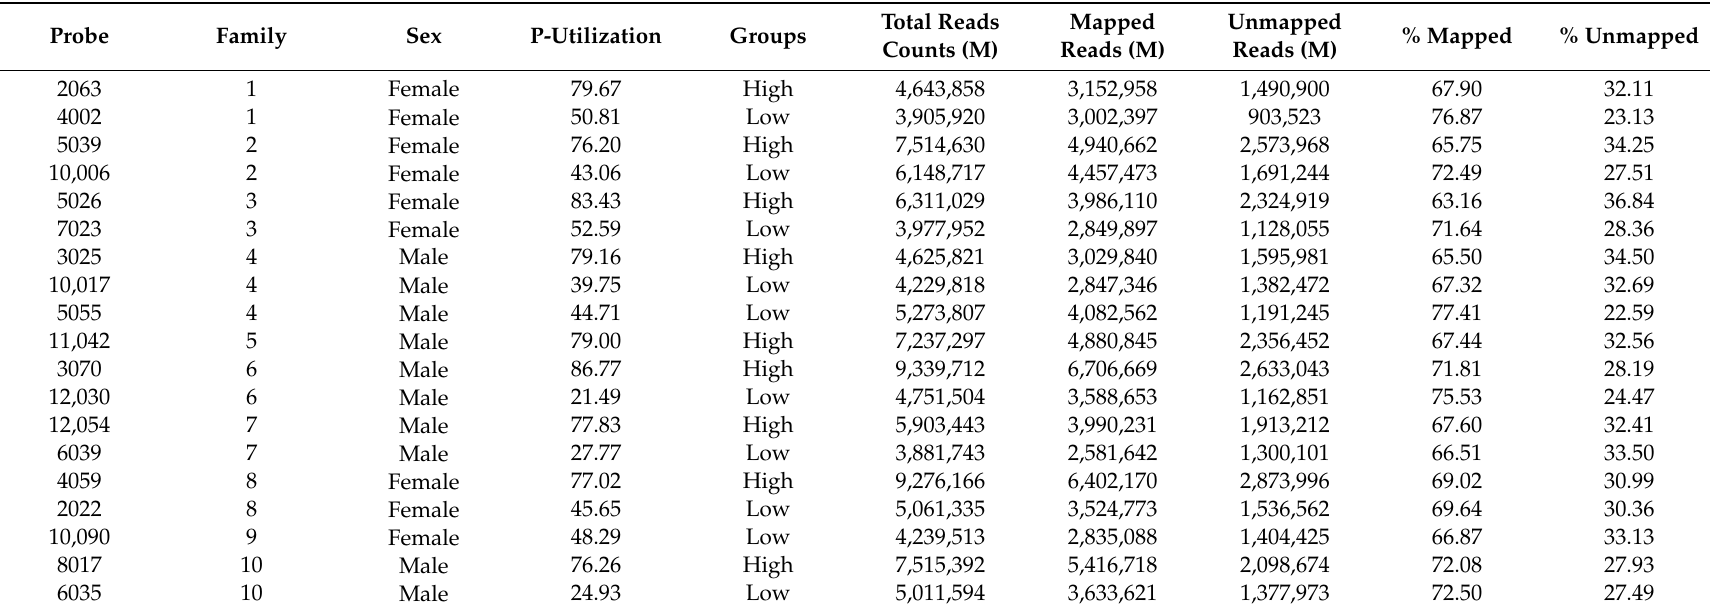
Table 1. Read counts in million (M) and mapping statistics, obtained from all